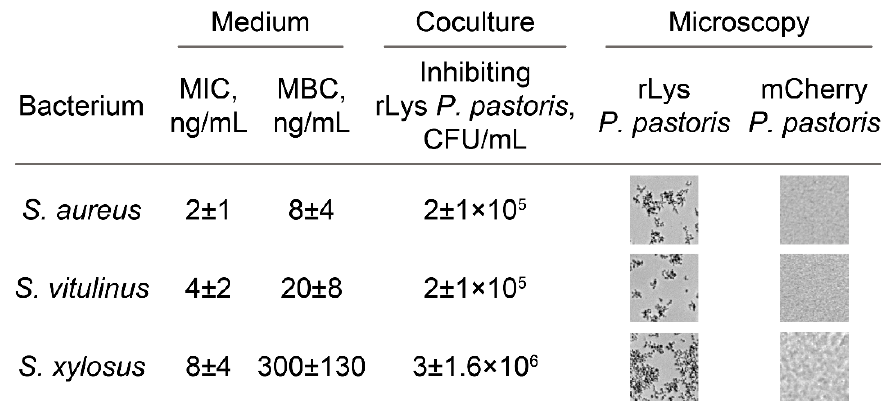
Figure 2. Antibacterial activity of rLys produced in a culture medium, and inhibitory activity of live rLys P. pastoris cell culture. The growth medium was collected after 1 d of cultivation. Live rLys P. pastoris cells were washed with a fresh medium before cocultivation with bacteria. ∼ 10 6 CFU / mL of indicator bacteria was used. Staphylococcus pasteuri , Staphylococcus warneri , Staphylococcus haemolyticus , Staphylococcus epidermidis , Macrococcus caseolyticus , Bacillus subtilis , Enterococcus faecium , Enterococcus faecalis and Escherichia coli were not inhibited by rLys P. pastoris and rLys up to 50 µ g / mL concentration. MIC—minimum inhibitory concentration, MBC—minimum bactericidal concentration.